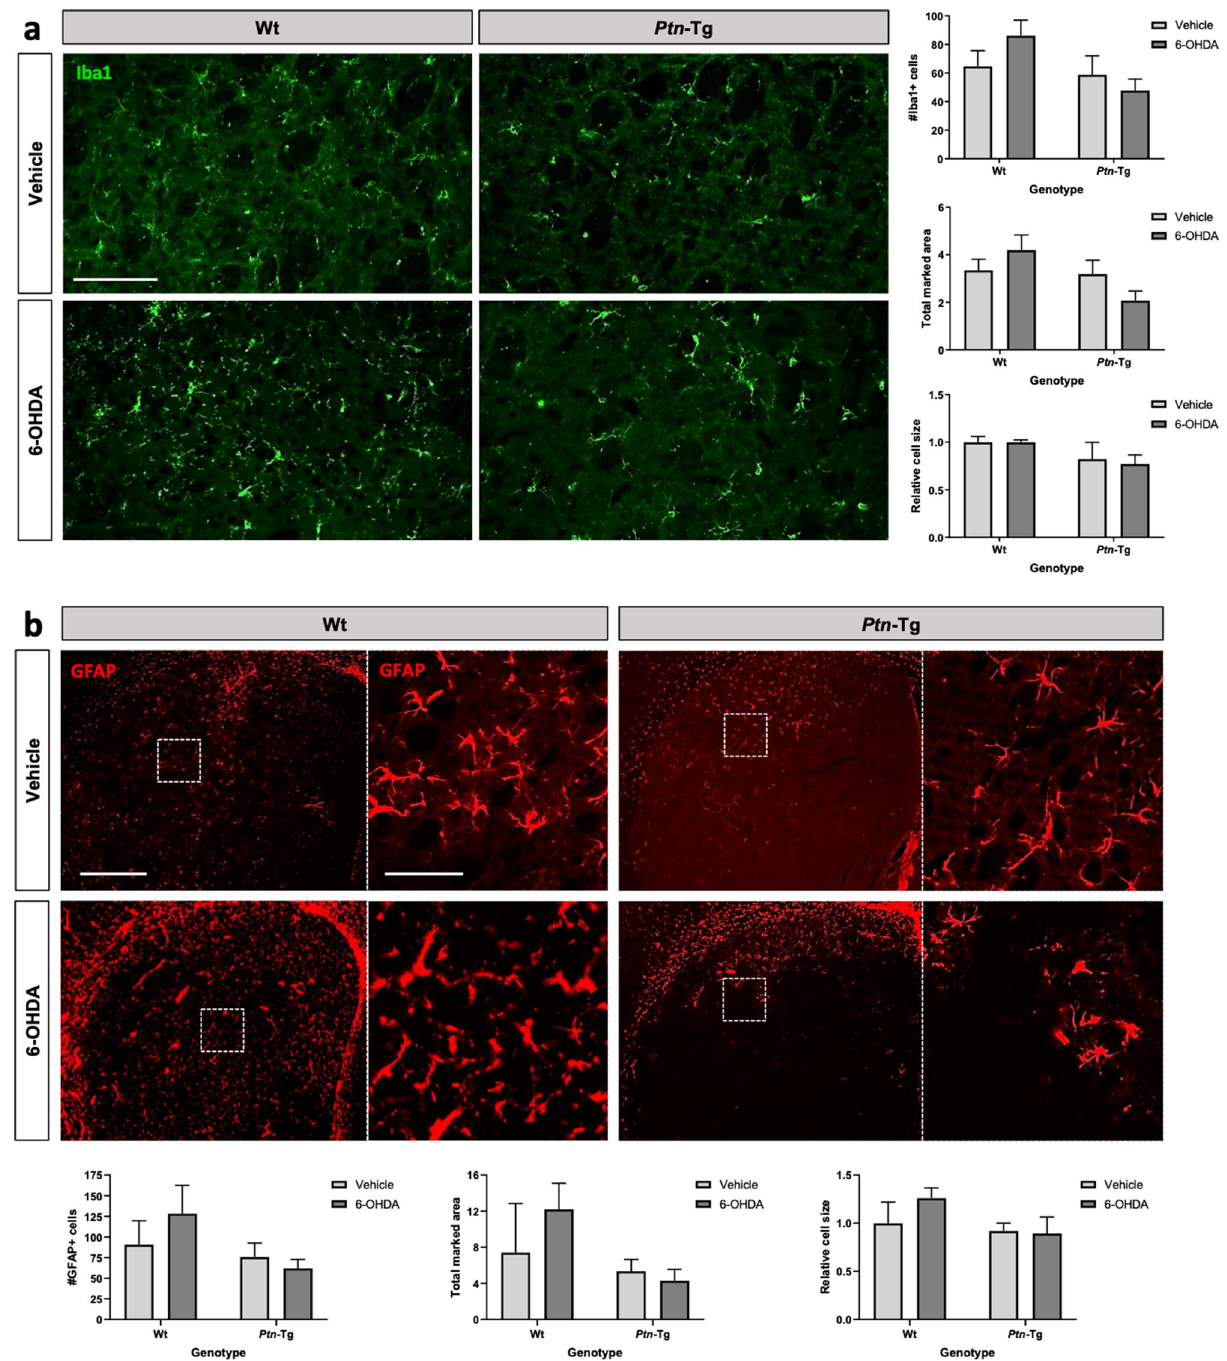
Figure 3. Effects of 6-OHDA on microgliosis and astrocytosis in the striatum of Wt and Ptn -Tg mice. Photomicrographs are representative from Iba1-immunostained ( a , green) and GFAP-immunostained ( b , red) striatal sections of vehicle and 6-OHDA-injected size of Wt mice and Ptn -Tg mice. Graphs represent quantification of data (mean ± S.E.M) obtained from the counts of Iba1+ cells, total Iba1 marked area and relative cell size ( a ) and from the counts of GFAP+ cells, total GFAP marked area and relative cell size ( b ) in the striatum. Scale bar in ( a ) = 100 μm; Scale bar in ( b ) = 500 μm (magnification image in dashed line, scale bar = 100